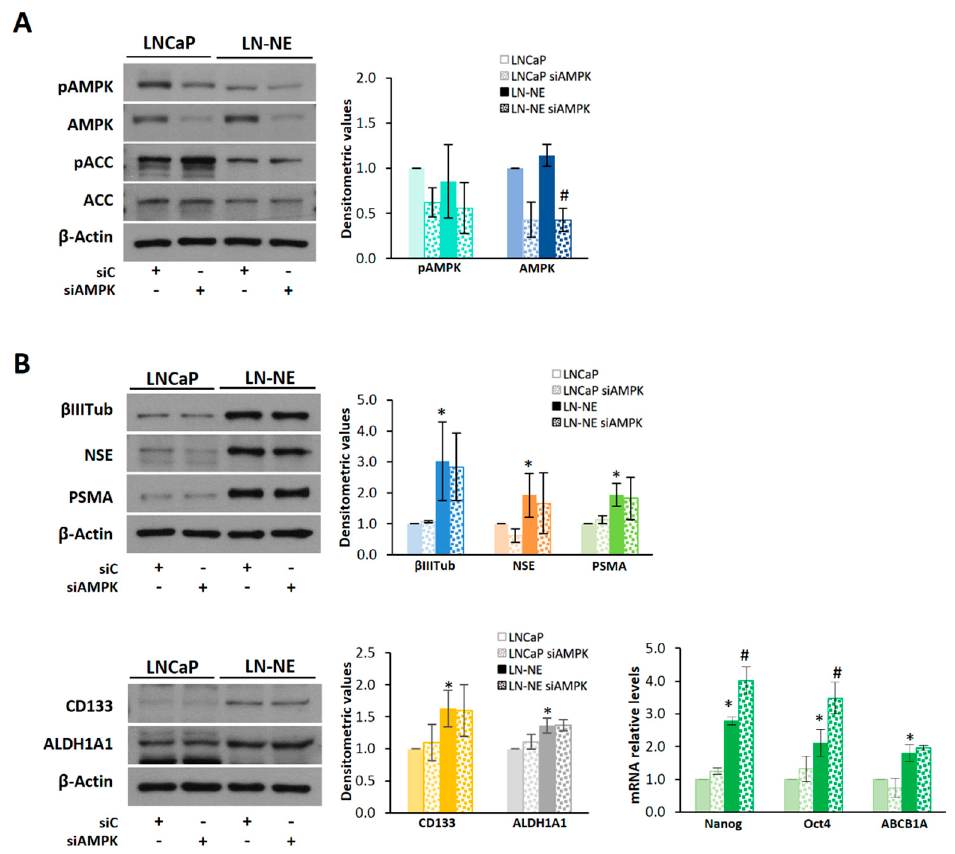
Figure 5. Knocking-down of AMPK in LN-NE cells increases the expression of Nanog and Oct4. ( A ) AMPK expression was downregulated by siRNA in LN-NE cells, and levels of the AMPK/ACC pathway proteins were determined by Western blot. ( B ) Levels of neuroendocrine and stem markers in AMPK knocked-down cells determined by Western blot and by qPCR. Densitometric values are shown on the right of each image. * p < 0.01 significant difference between LN-NE and LNCaP cells by two-way ANOVA and Sidak’s multiple comparisons test, # p < 0.05 significant difference between siAMPK and siC cells.